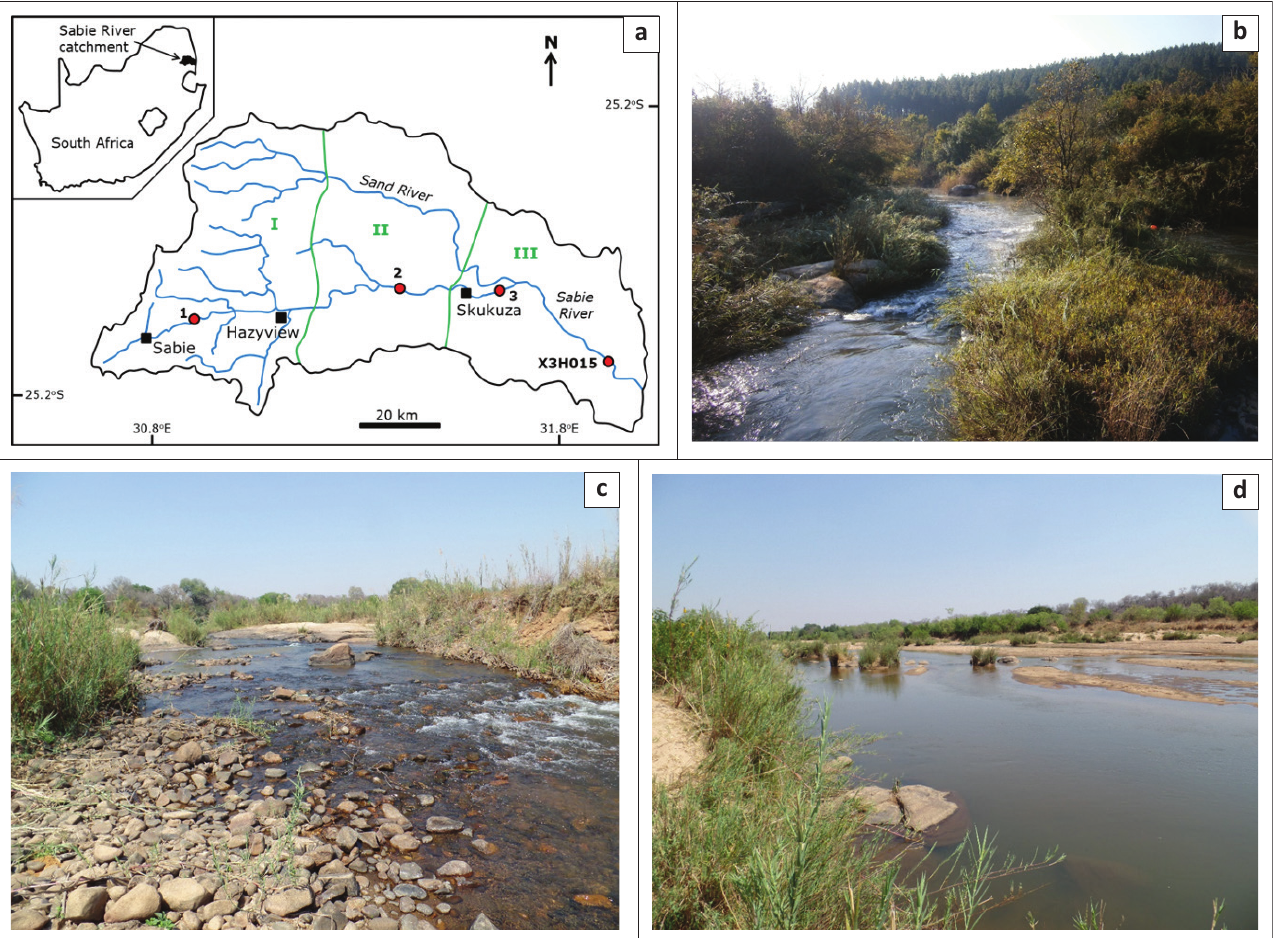
FIGURE 1: (a) Location of the Sabie River in northeast South Africa, showing the locations of sites named in the text (red dots), river gauging station X3H015 and the three river geomorphic zones (marked after Eze & Knight 2018) of (I) highland zone of gorges and bedrock-forced meanders; (II) low to moderately sinuous planform controlled mixed beds; (III) low sinuosity, fine grained beds and floodouts. Zones are separated by green lines on the map. (b) Photo of the Sabie River within Zone I at Bergvliet (site 1 on panel a); (c) photo within Zone II at Kruger Gate (site 2 on panel a); (d) photo within Zone III near the Sabie-Sand confluence (site 3 on panel